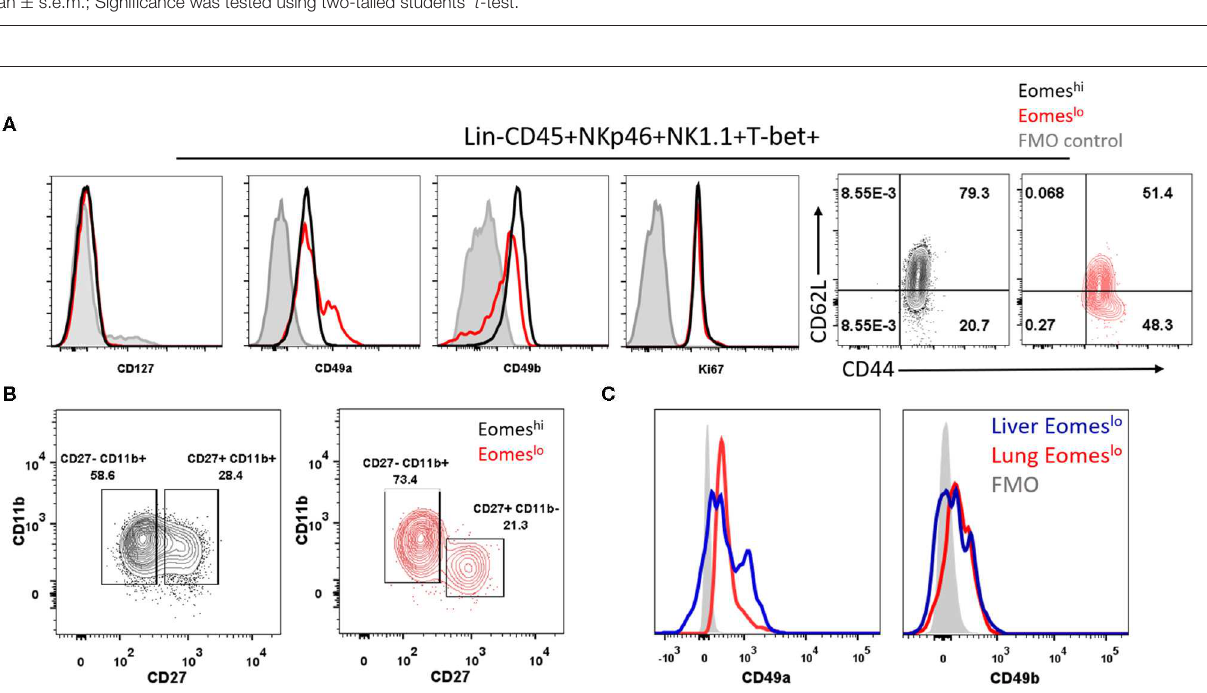
FIGURE 3 | day 4. The mice were then sacrificed at day 10 and lungs were harvested and analyzed. (B) Eomes lo and Eomes hi cells in Eomes-GFP mice (Red) overlaid with Eomes FMO (blue) (left panel). Two distinct populations can be seen upon running live cells under flow cytometer; Sorting efficiency ∼ 99% middle panel); Donor cells after transfer of CD45.2 + Eomes hi -GFP + cells into CD45.1 mice (right panel). (C) Eomes (MFI) after transfer of donor derived Eomes hi GFP + cells in cancer-bearing (B16F10) and cancer-lacking (mock) hosts at day 10. No significant difference in Eomes MFI was observed between cancer and mock mice. (D) Frequency of Eomes lo GFP − cells amongst donor NK cells at day 10 post-injection of B16F10 cells (E) Flow plots and graphs show near absence of Eomes lo cells in T-bet KO mice ( ∼ 0.8%) compared to WT mice ( ∼ 29.1%), indicating that T-bet is needed for development of Eomes lo cell development (Red—NKp46 + NK1.1 + cells;